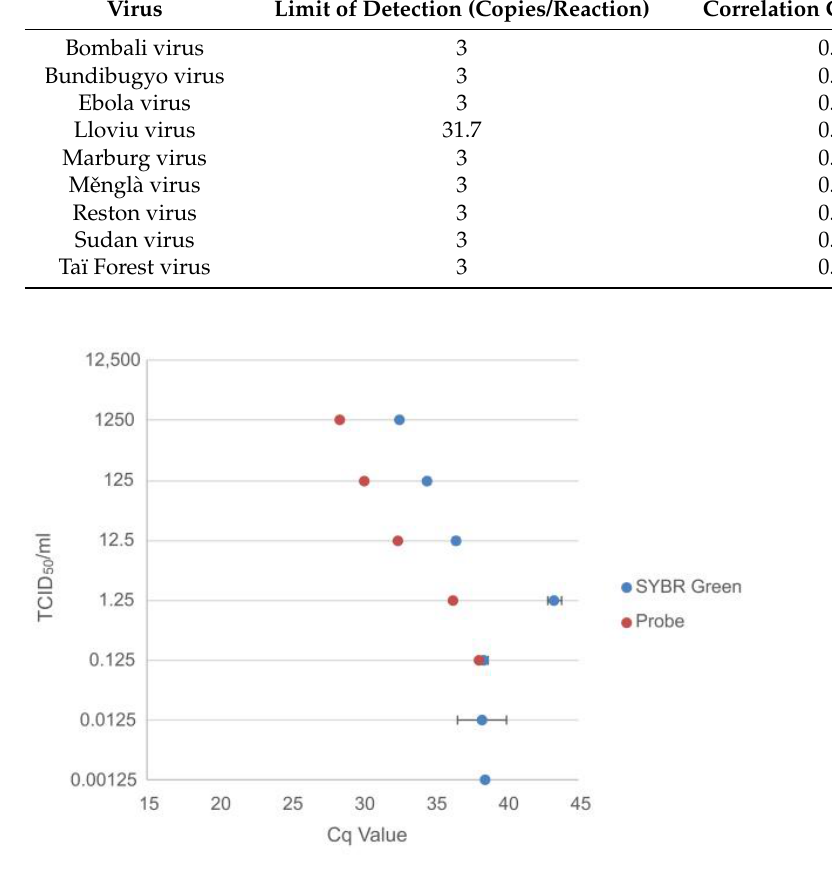
Figure 5. Comparison of the Cq values for the probe-based assay and the average Cq values for the SYBR Green assay for the titrated (TCID 50 /mL) serially diluted Ebola virus. The probe-based assay detected MARV up to a concentration of 0.02 TCID 50 /mL